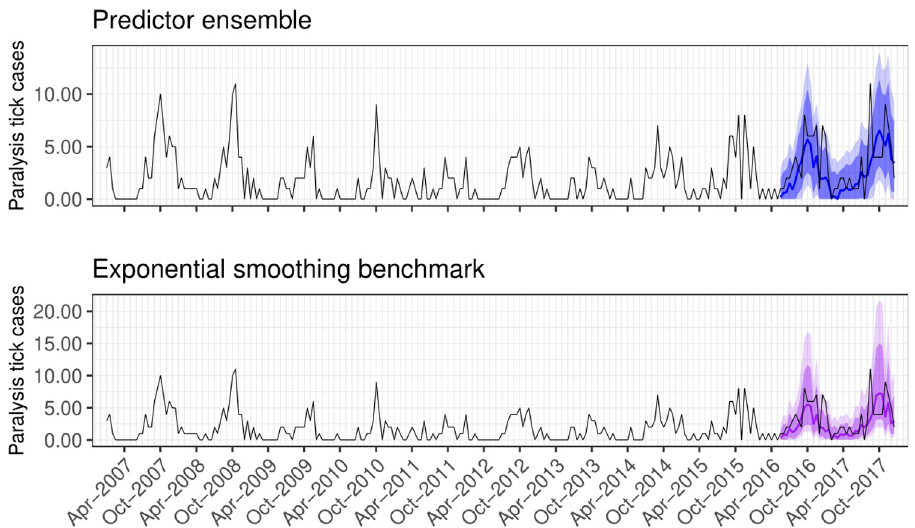
Fig 4. Forecasts from competing models. Forecasts of paralysis tick admissions (observed counts shown as the black line) generated by the predictor ensemble (blue shading) and the ETS benchmark model (purple shading). For both forecasts, dark shading shows 80% and light shading shows 95% prediction intervals. Note the difference in scales of the y-axes.